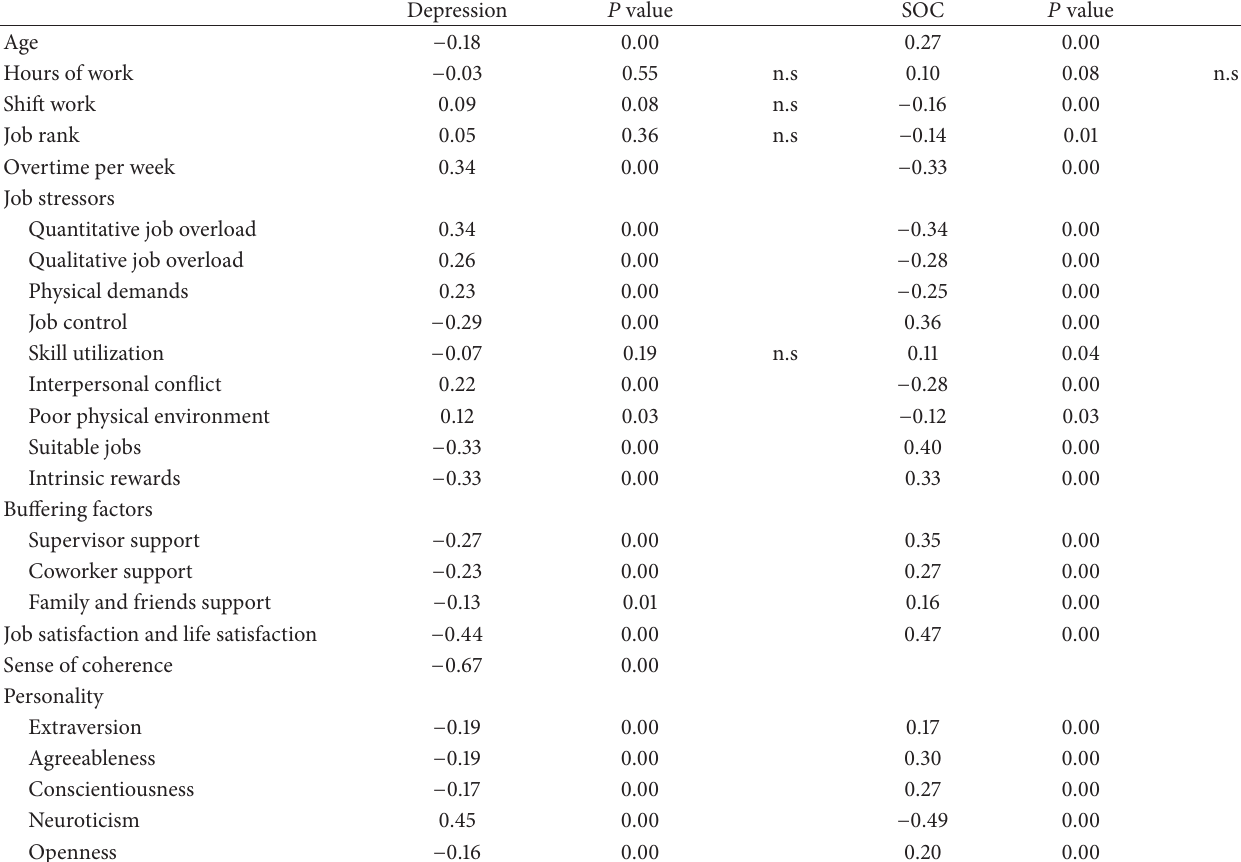
Table 2: Spearman’s correlation between depression, personality, sense of coherence, and job